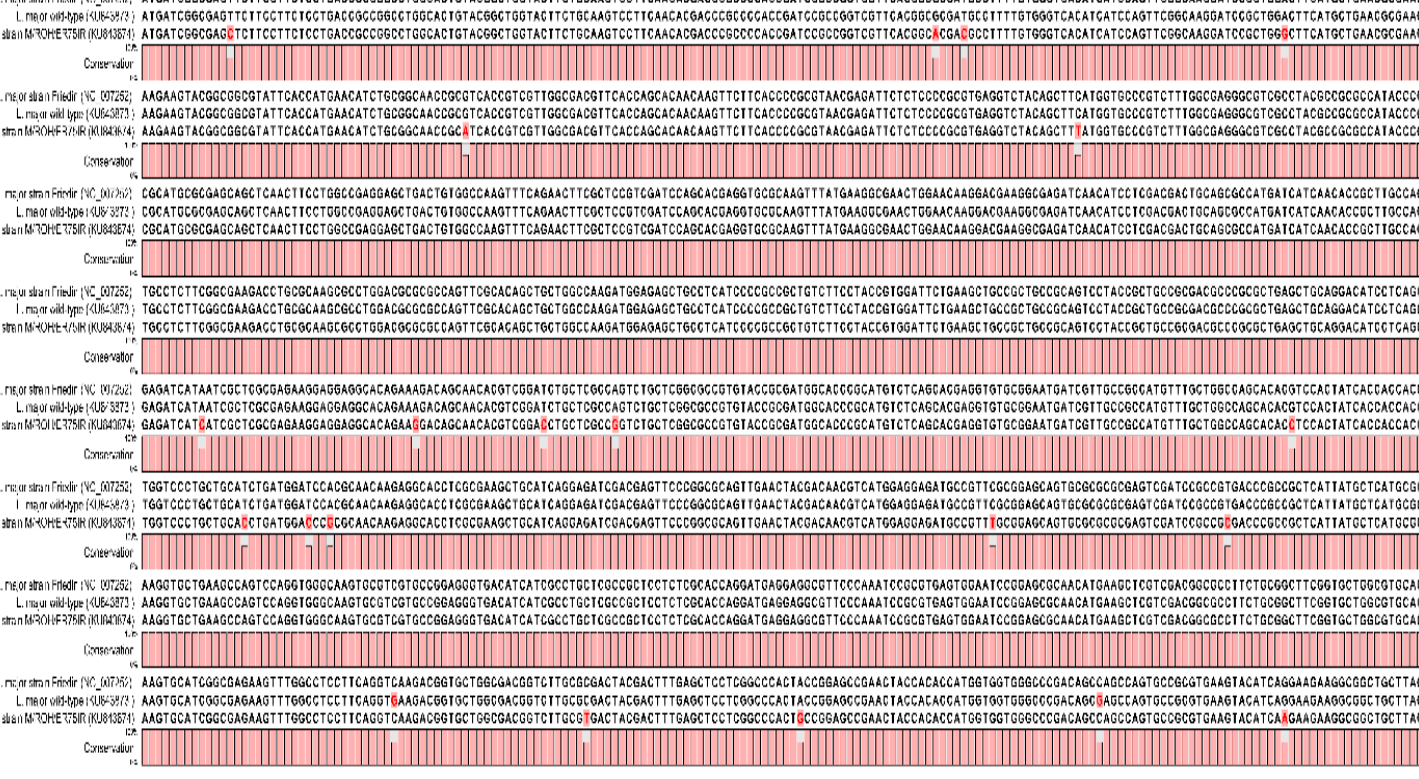
Figure 2. Multiple nucleotide sequence alignment of different strains of L. major . There are 21 nucleotide changes in these sequences, including 14 synonymous and seven non-synonymous substitutions. The nucleotide changes were shown by red letters in red boxes.